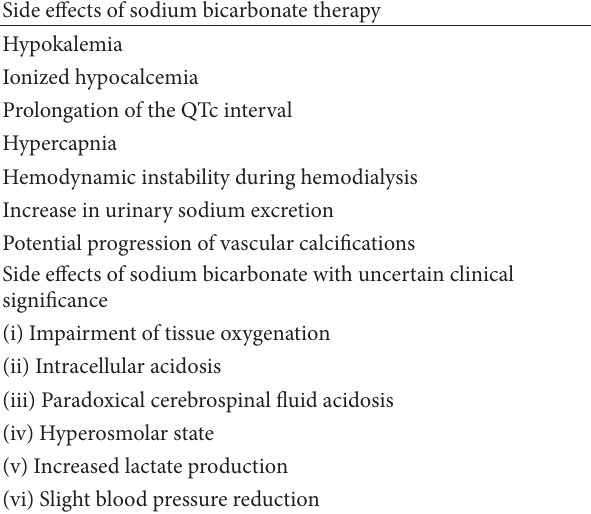
Table 4: Side effects of sodium bicarbonate